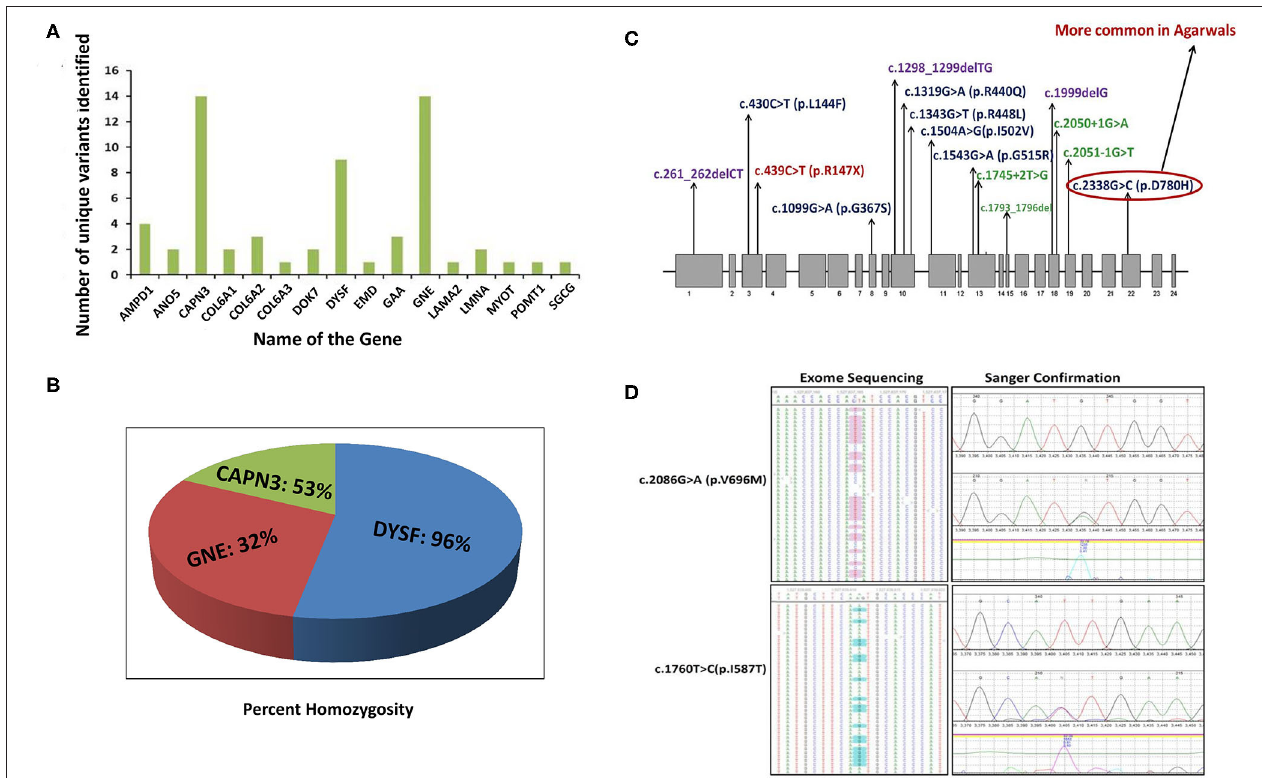
FIGURE 2 | Unique pathogenic variants and percent homozygosity identified in major myopathy genes. (A) Number of unique pathogenic variants identified in major myopathy genes. (B) The percentage of homozygosity observed in the major myopathy subtypes. Among the three major myopathy subtypes, 96% of the limb-girdle muscular dystrophy R2 (LGMDR2) patients caused by variants in DYSF gene were identified with homozygous variants. (C) Mutation spectrum of CAPN3 gene: CAPN3 variants identified in the current study are distributed throughout the gene. There is no specific mutation hot spot region but 3 variants are located in exon 10 indicating it as more unstable region prone to genetic variation. (D) Two common variants in GNE gene: The two common variants in GNE gene were detected in exome sequencing with high confidence and also further confirmed by Sanger sequencing. Left side panel indicates the variants confirmation by exome sequencing. Right side panel indicates the variants confirmation by Sanger